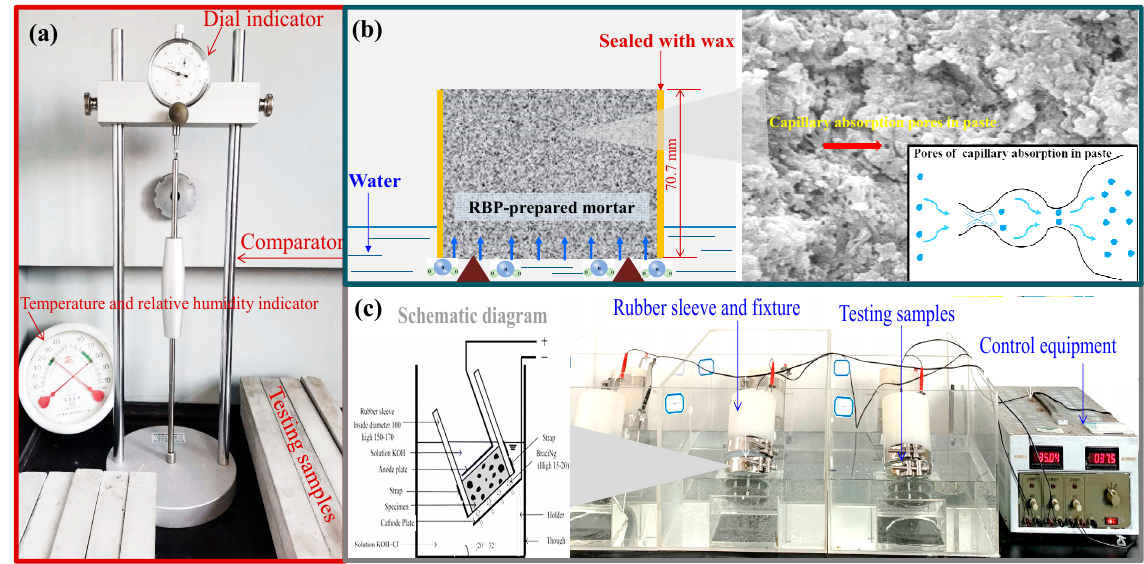
Figure 4. Test ( a ) drying shrinkage test; ( b ) water absorption test; ( c ) Chloride diffusion test.